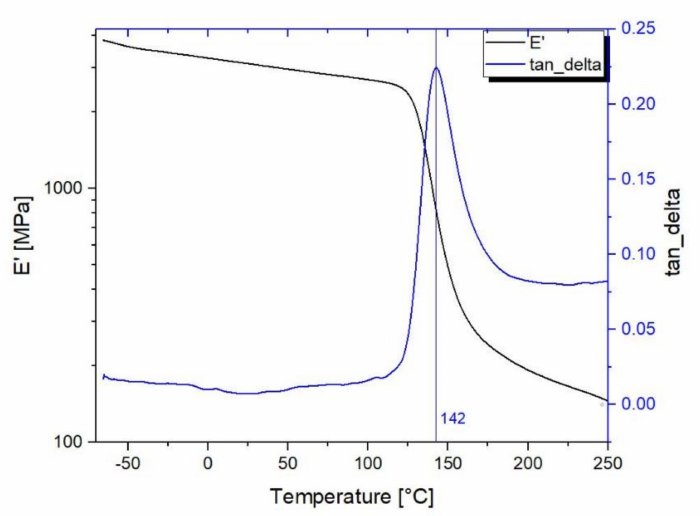
Figure 8. DMTA storage modulus E’ of 3D-printed PEEK as a function of temperature.